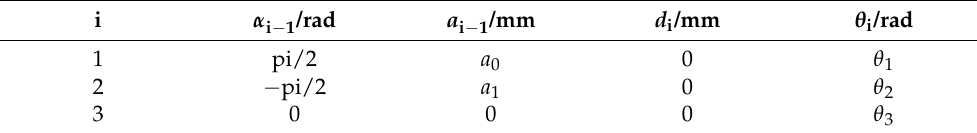
Table 1. RS010N connecting rod